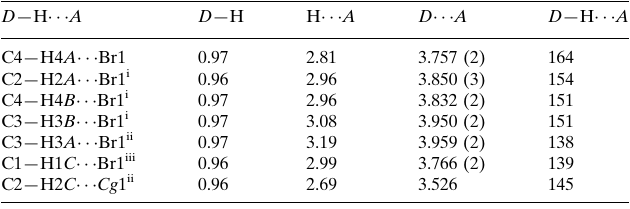
Hydrogen-bond geometry (A˚ , (cid:4) ). Cg 1 is the centroid of the benzene